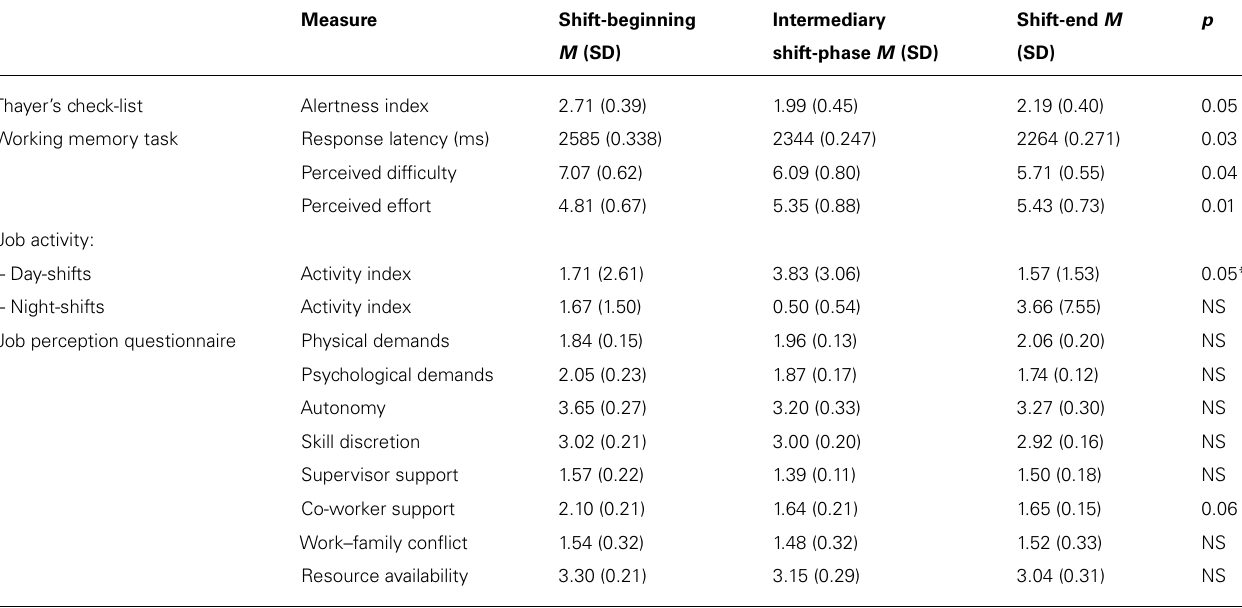
Table 1 | Operators’ alertness, working memory performance, and job activity on each shift-phase.